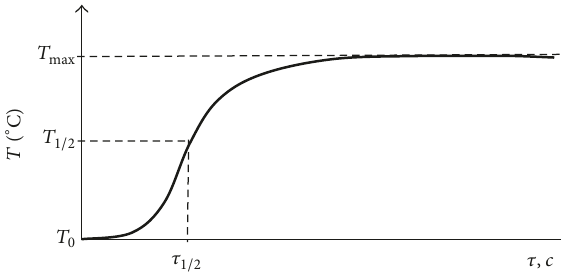
Figure 2: The typical form of changing temperature fixed on the sample back